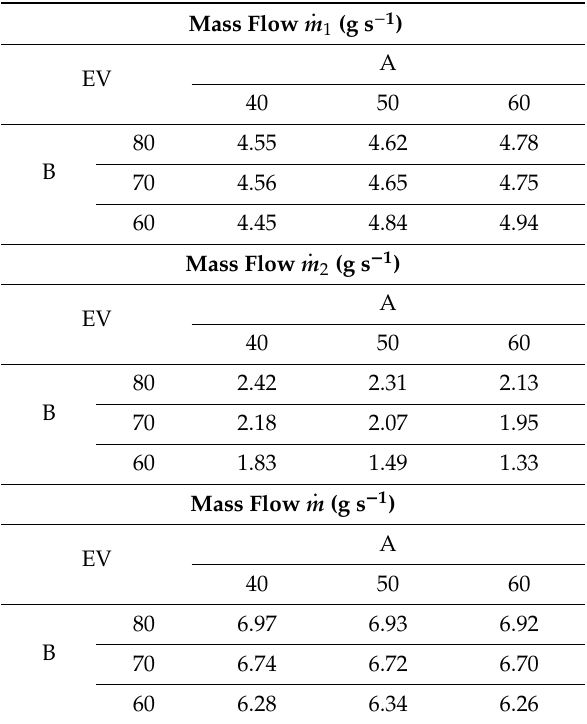
Table 3. Influence of expansion valves openings on mass